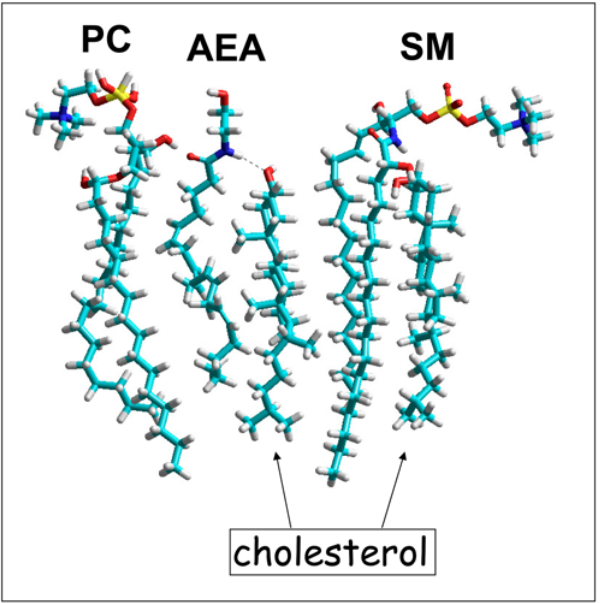
Figure 2. Molecular modeling of the anandamide-cholesterol complex in the membrane environment. The anandamide (AEA)- cholesterol complex was generated in vacuo, and subsequently merged with a phosphatidylcholine molecule (PC). The flexible acyl chains of PC could satisfactorily fit with AEA, allowing PC to interact with the AEA- complex. A molecule of sphingomyelin (SM) interacting with cholesterol was added to the system as a representative lipid raft component. The SM-cholesterol complex could also fit with the AEA-cholesterol complex. Namely, in the AEA-cholesterol complex, the a face of cholesterol is fully accessible for the sphingosine chain of SM. This molecular modeling study indicates that AEA can bind to cholesterol in both the PC-rich fluid (Ld) phase and the SM-rich (Lo) phase of the plasma membrane. In particular, the H-bond between cholesterol and AEA is still present after introducing these membrane lipids in the system. The total energy of the system is 180.68 kcal.mol 2 1 for the cholesterol-sphingosine complex ( 2 14.43 kcal.mol 2 1 for AEA bound to cholesterol). All models were obtained with the Polak-Ribiere algorithm (for geometry optimization) and then submitted to Monte Carlo simulations.